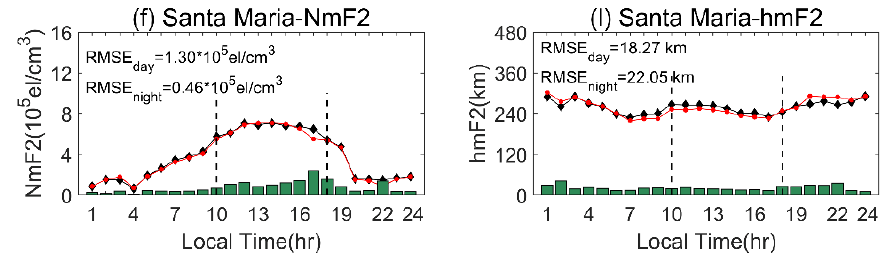
Figure 6. Hourly mean of NmF2 ( left column ) and hmF2 ( right column ) of the COSMIC-2-IPPVs (black squares) and ionosonde-IPPVs (red squares), respectively, during the approximately 2-year period studied at each station, and hourly RMSEs (green bars). The two vertical dashed lines in each subfigure denote the start and end moments of the daytime.